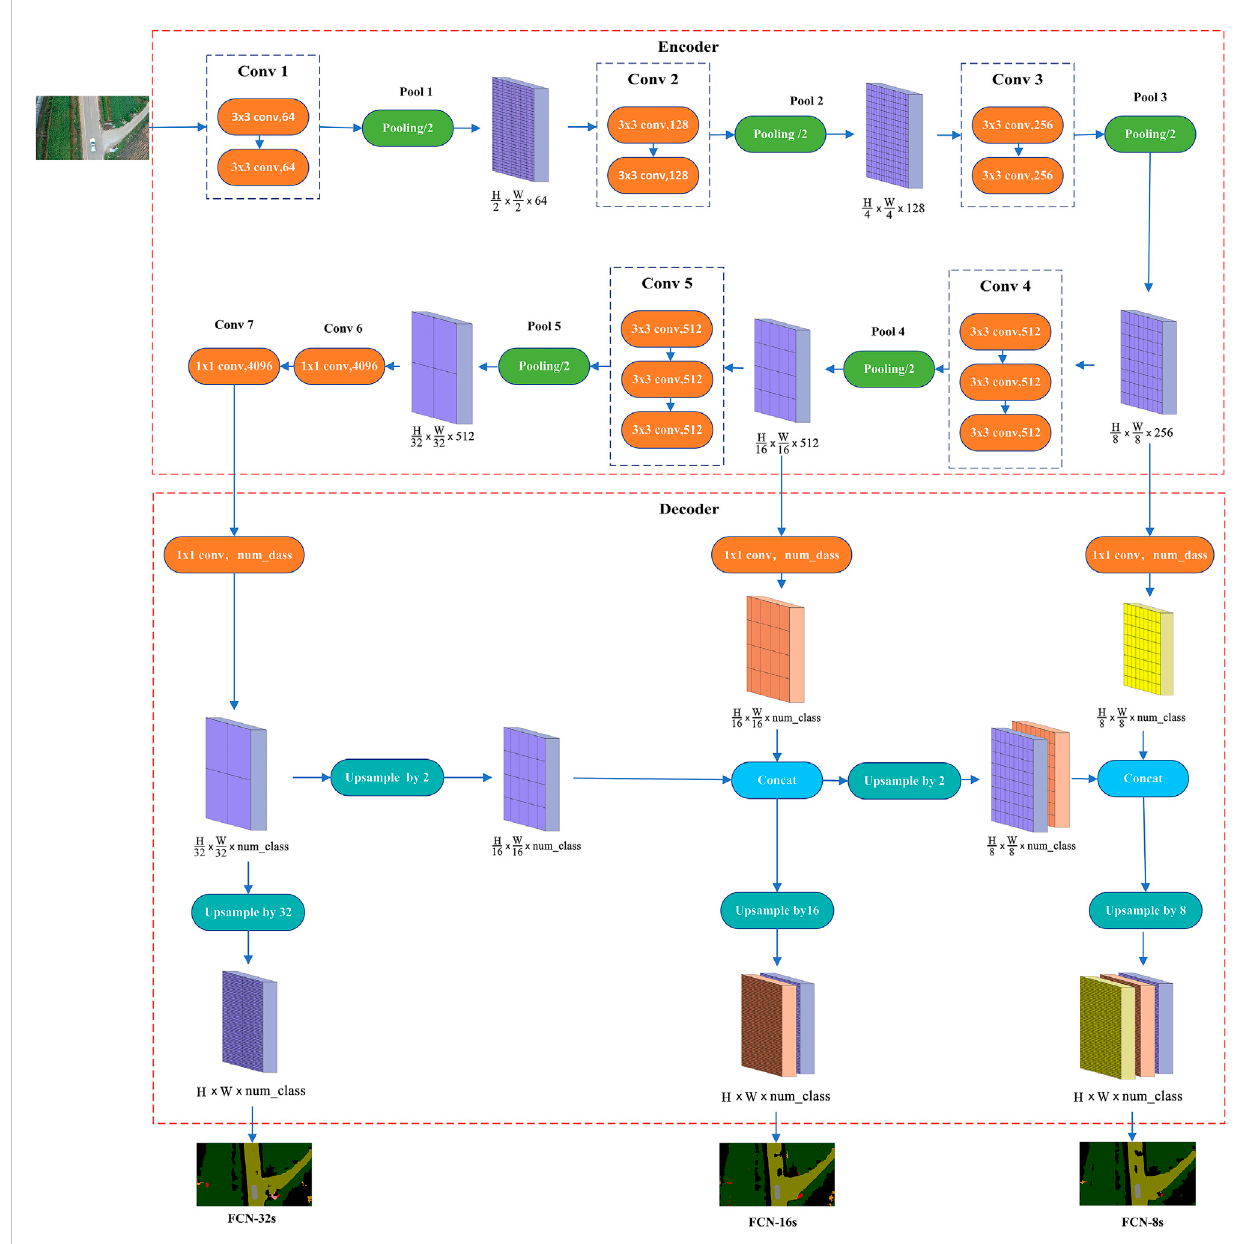
FIGURE 3 Deeplearningnetworkstructure,includingencoderanddecoder.ThedecoderpartshowsthedecodingprocessofFCN-32s,FCN-16s,andFCN-8s respectively. (A) FCN-32s; (B) FCN-16s; (C)